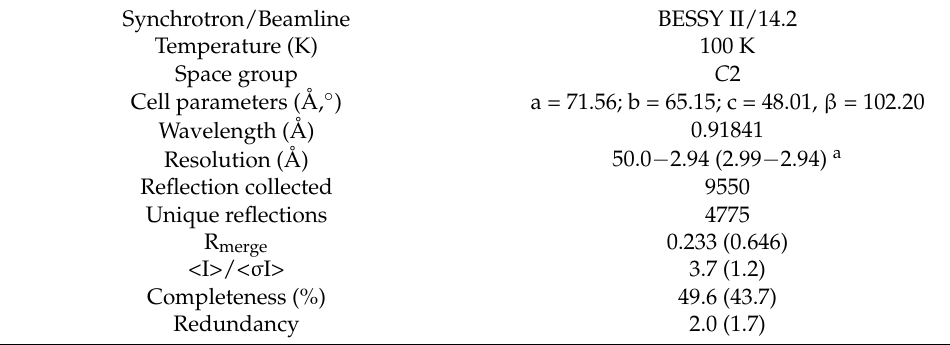
Figure 8. Crystallization drops and X-ray diffraction images for the CysZ9 peptide crystallized in ( a ) needle-shaped form from 2.4 M sodium malonate pH 6.0, and in ( b ) cuboid form from 0.2 M MgCl 2 , 10% MPD, 0.05 M sodium cacodylate pH 6.5, 0.001 M spermine. ( c ) Sample diffraction image recorded for crystal from ( a ); ( d ) sample diffraction image recorded for crystal form ( b ). Table 2. Crystallographic data and data collection parameters for CysZ9.